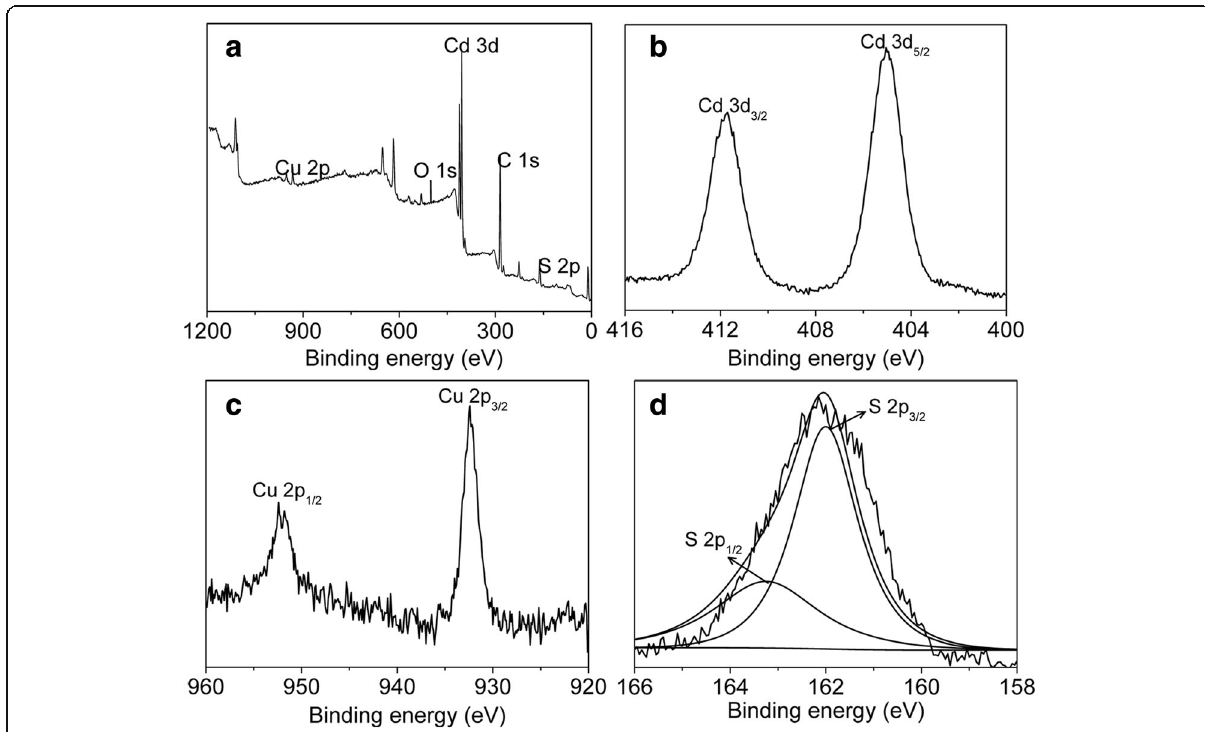
Fig. 5 XPS spectra of CdS:Cu(I) NCs. a Survey spectrum. b Cd 3d. c Cu 2p. d S